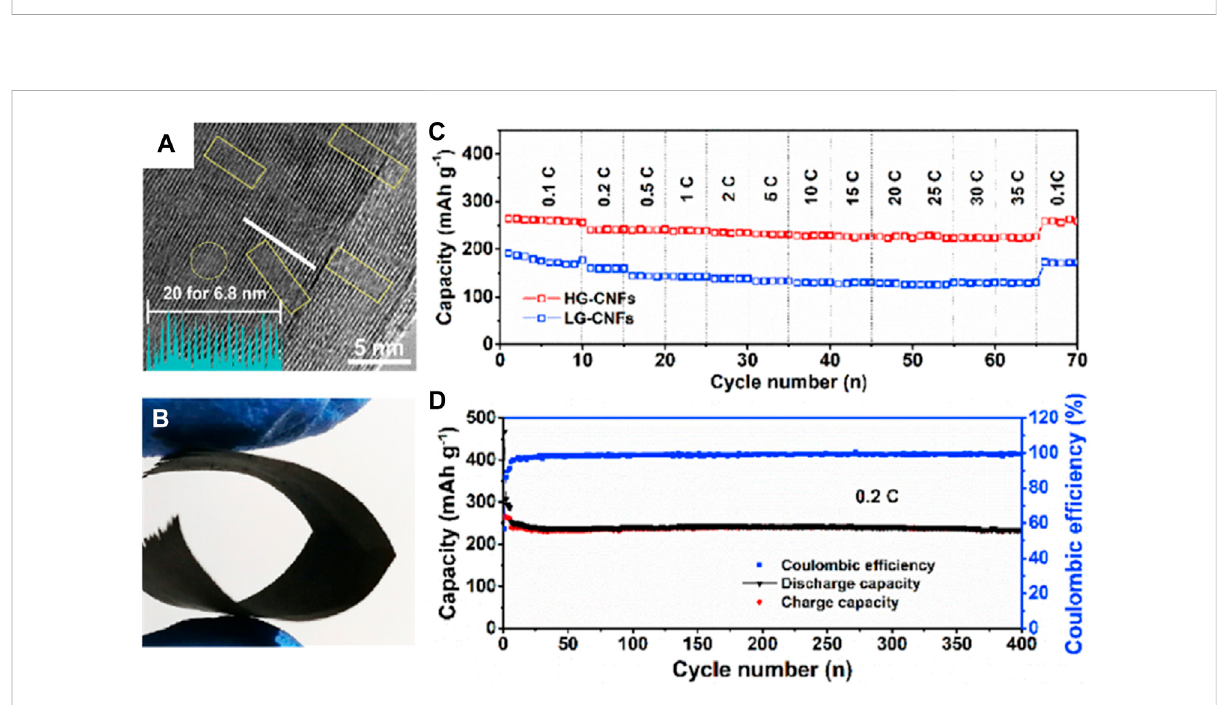
FIGURE 9 (A) HRTEM image of graphitic. (B) Digital photograph of folded HG-CNFs. (C) Rate capabilities from 0.1 to 35 C for LG-CNFs and HG-CNFs. (D) Long-term cyclestabilityandcorrespondingCoulombic ef fi ciency ofHG-CNFsat0.2